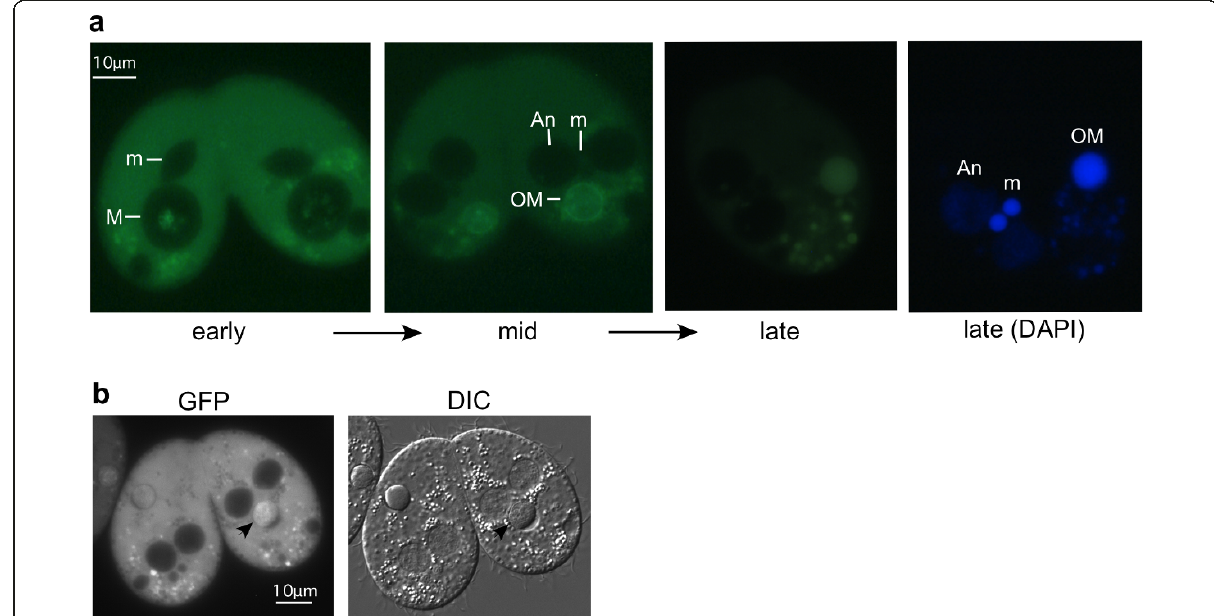
Figure 8 Thd14 concentrates inside the macronucleus immediately prior to pycnosis . a Fluorescence microscopy images of live conjugating pairs showing localization of GFP-Thd14 at three points in conjugation designated “ early ” (before meiosis), “ mid ” (after meiosis, mid- development of anlagen) and “ late ” (after pair separation, prior to macronuclear reabsorption). M, macronucleus; An, anlagen; m, micronucleus. Live cells were concentrated and mounted in 2% methylcellulose. b DIC and fluorescence microscopy images of a live conjugating pair showing GFP concentration over condensed chromatin regions in degrading macronuclei (arrows). Cells were prepared as in part